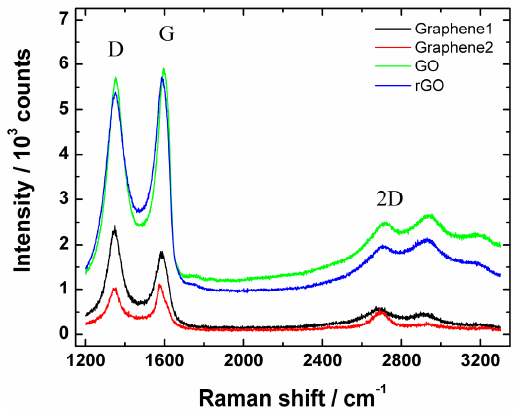
Figure 4. Raman spectra of graphene nanopowder from Graphene Supermarket (Graphene1), graphene nanoplatelet aggregates from Strem Chemicals (Graphene2), graphene oxide (GO) and reduced graphene oxide (rGO).